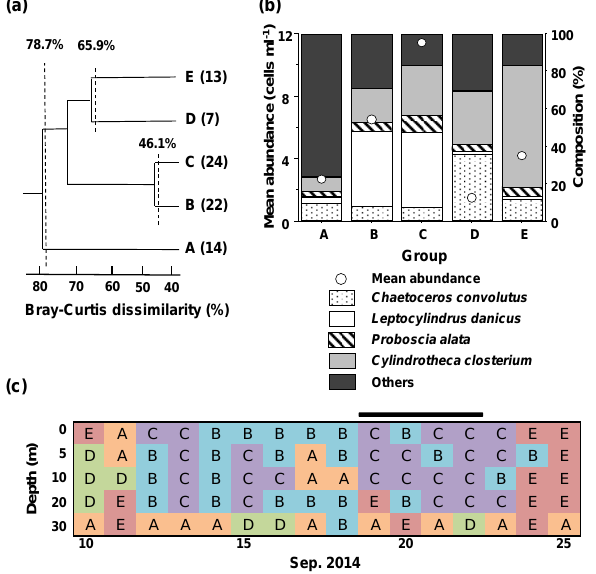
Figure 6. (a) Results of cluster analysis based on diatom cell den- sity in the Chukchi Sea from 10 to 25 September 2013. Five groups (A to E) were identified at 46 to 78% Bray-Curtis dissimilarity con- nected using UPGMA. Numbers in parentheses indicate the number of samples in each group. (b) Mean abundance and species compo- sition of each group. (c) Vertical and temporal distribution of each group. Solid bar in (C) indicates the timing of a strong wind event.